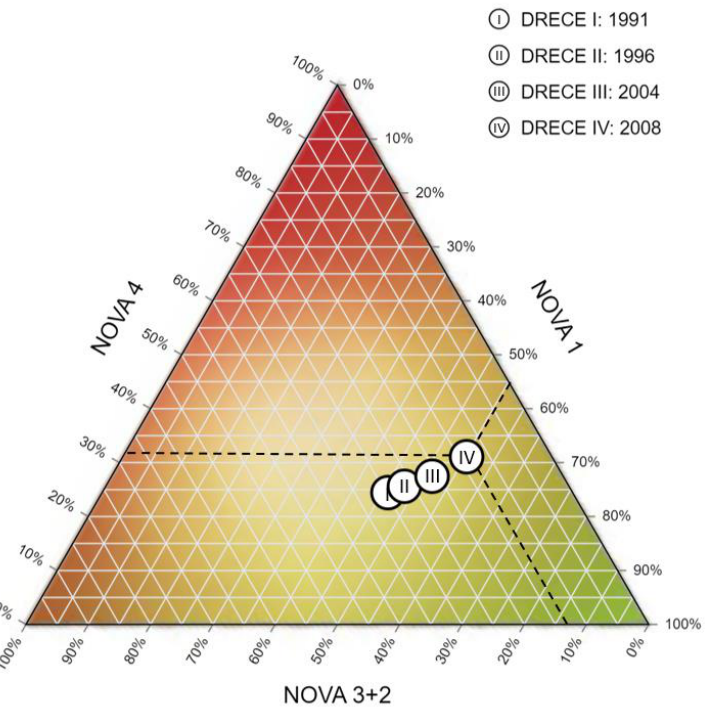
Figure 2. Ternary diagram of the average percentage of energy intake from the NOVA classification by the Spanish population over by the Spanish population over time.